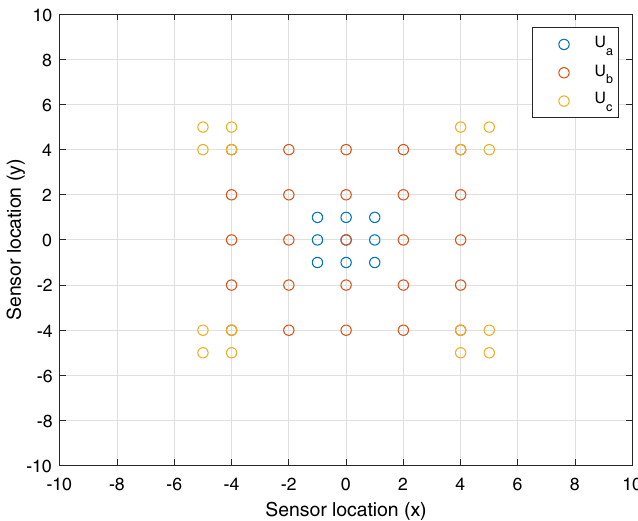
Fig. 7 RMSE versus snapshots, SNR